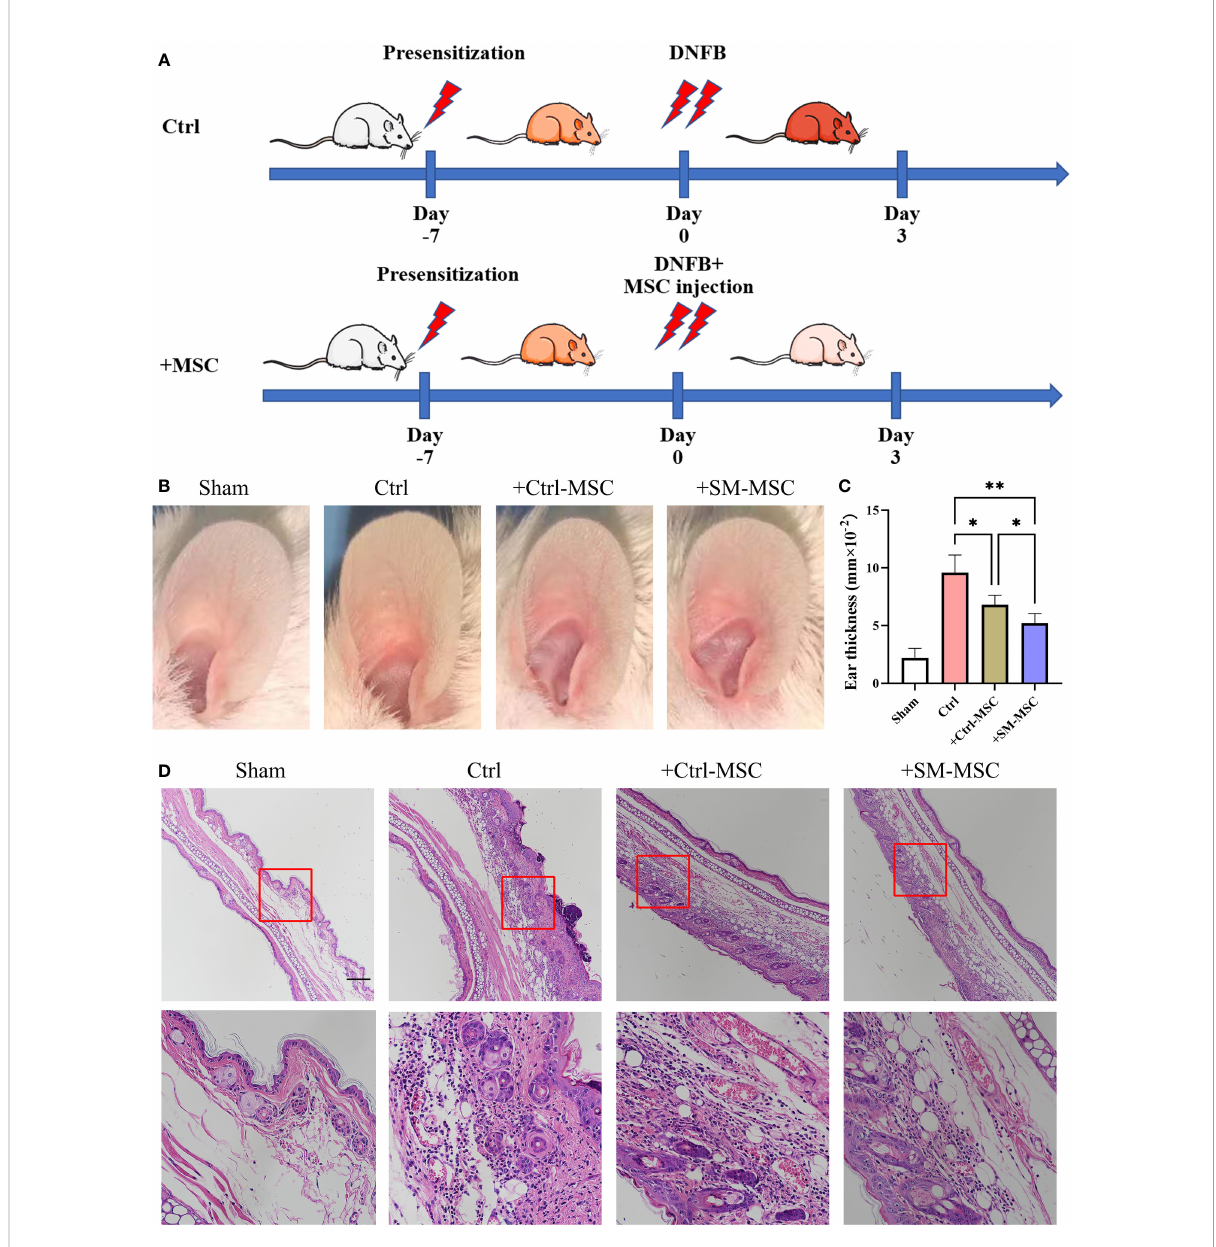
FIGURE 3 MSCs alleviate DNFB-induced contact hypersensitivity. (A) Schematic of experimental protocol for establishing mice contact hypersensitivity and the subsequent MSC treatment. (B) Representative images of ears from mice. (C) Ear thickness of different groups, n = 5 per group. (D) Histopathologic analysis was determined 2 days after injection of the cells, scale bar = 200 m m. Data are shown as mean ± SD, *P < 0.05, **P <